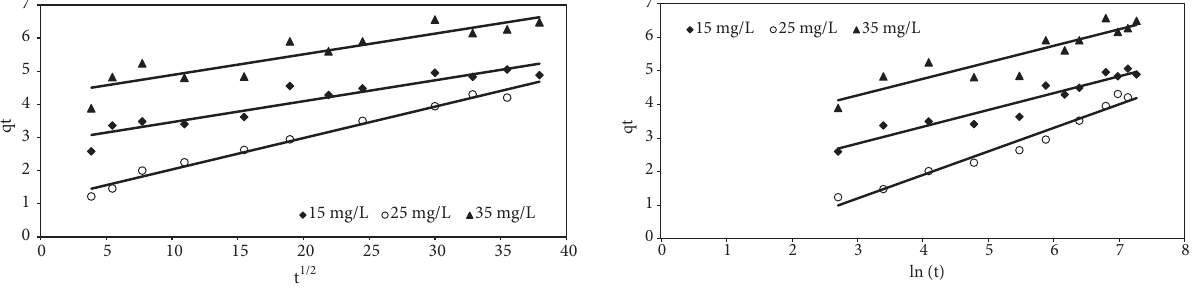
The integrated Elovich equation is given as: